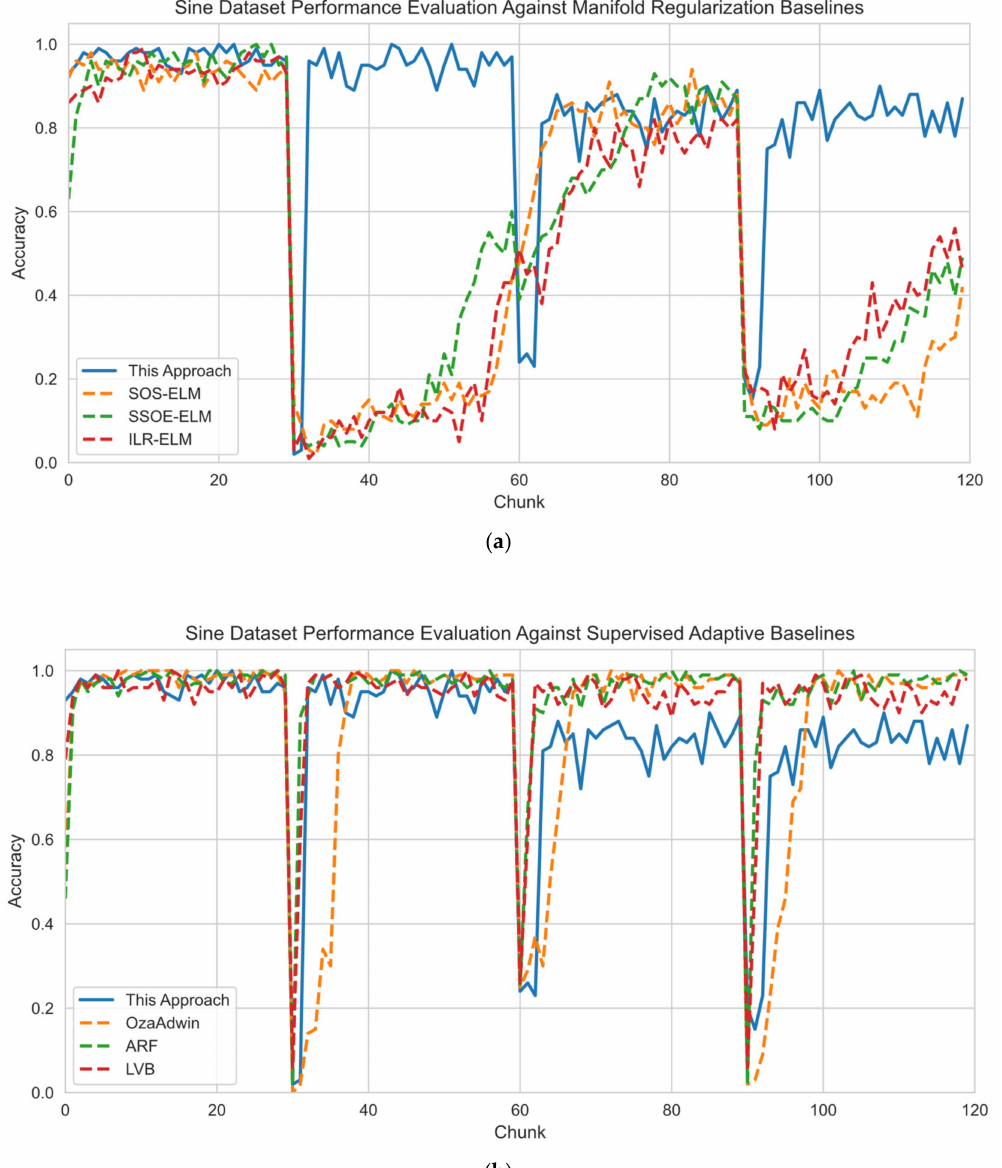
Figure 2. Sine dataset performance evaluation. ( a ) The performance of this proposed approach against other manifold regularization approaches. ( b ) The performance of this proposed approach against other fully supervised